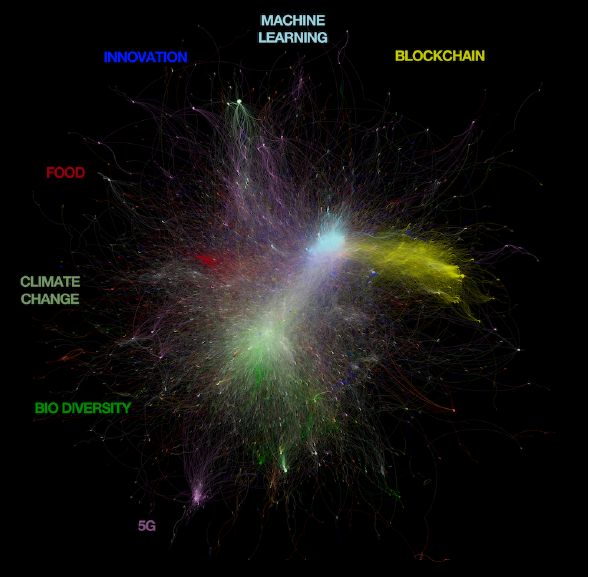
Figure 4. Retweet network: the edges between two users are coloured according to the associated hashtag of the